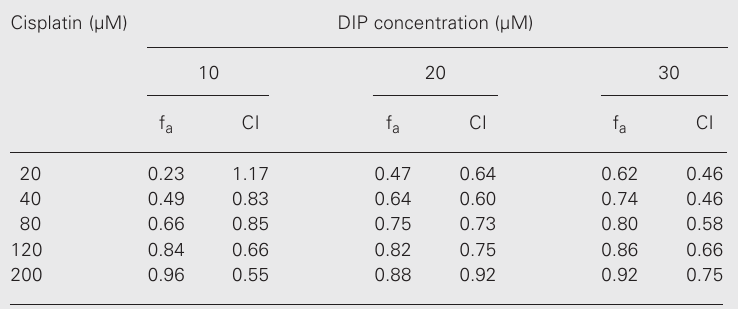
Figure 2. Effect of dipyridamole (DIP) on the survival index of HEp-2 cells. Cells were treated with several DIP concentra- tions (0, 5, 10, 15, 20 and 30 µM) for 1 h at 37 º C in the pres- ence of 5% CO 2 . Each column represents the mean ± SD for two experiments each per- formed in duplicate. *P < 0.005 compared to no DIP (ANOVA).